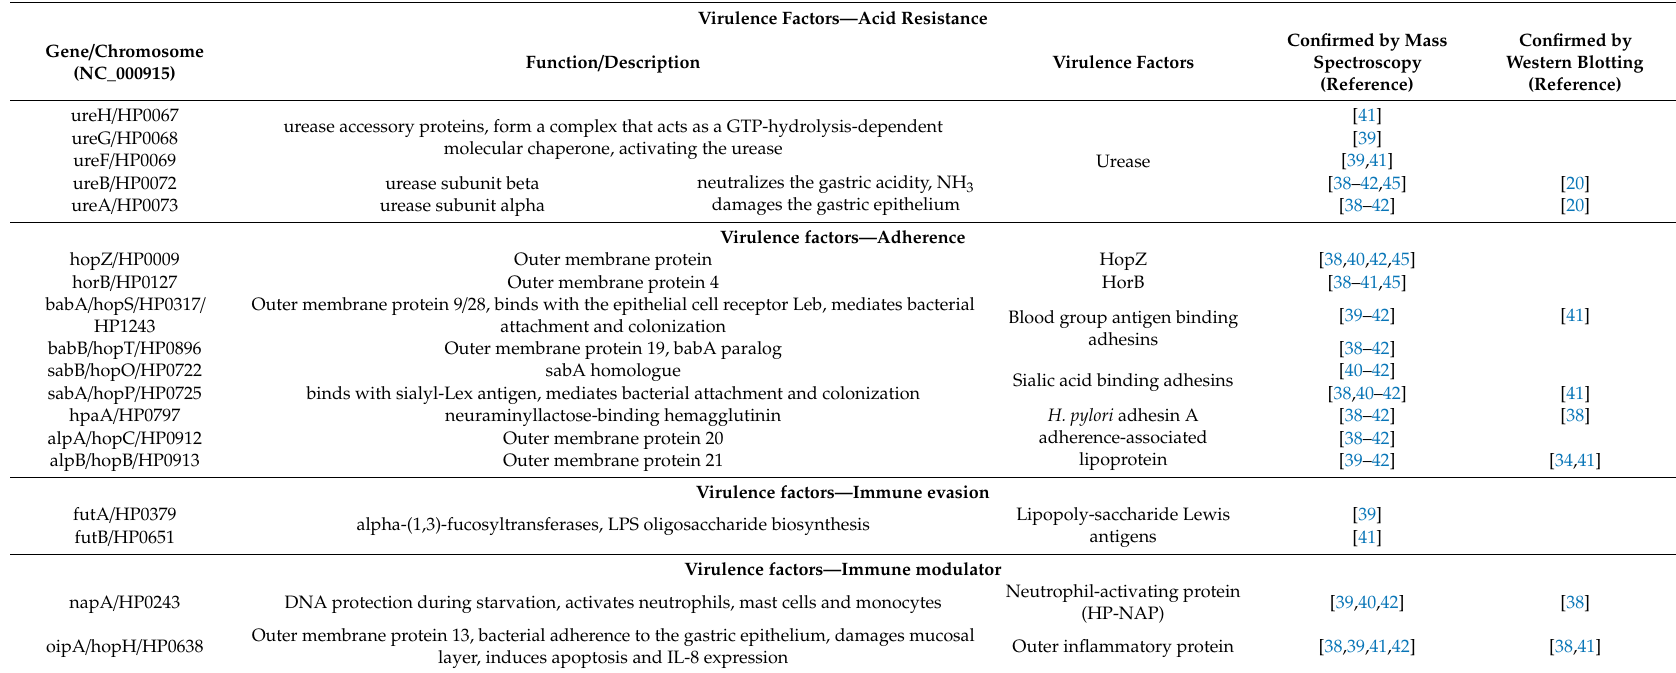
Table 2. Proteins detected in H. pylori